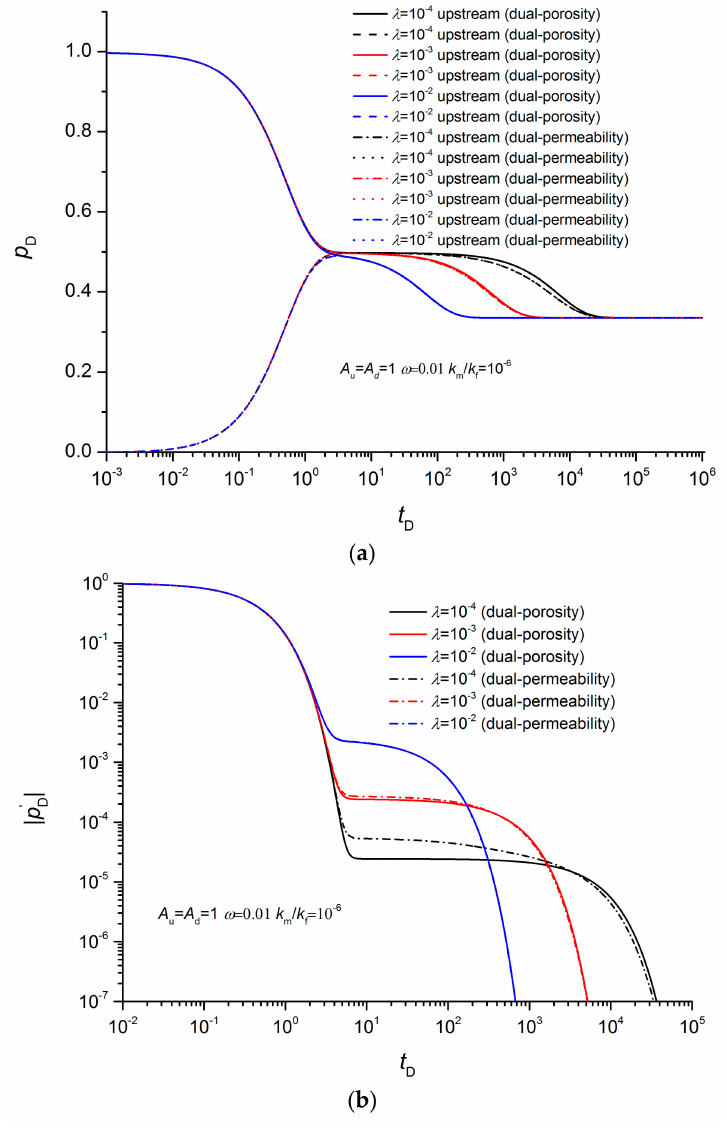
Figure 9. E ff ect of the interporosity flow coe ffi cient on pulse decay tests for dual-permeability cores (fixed matrix-fracture permeability ratio). ( a ) Pressure history. ( b ) Pressure derivative